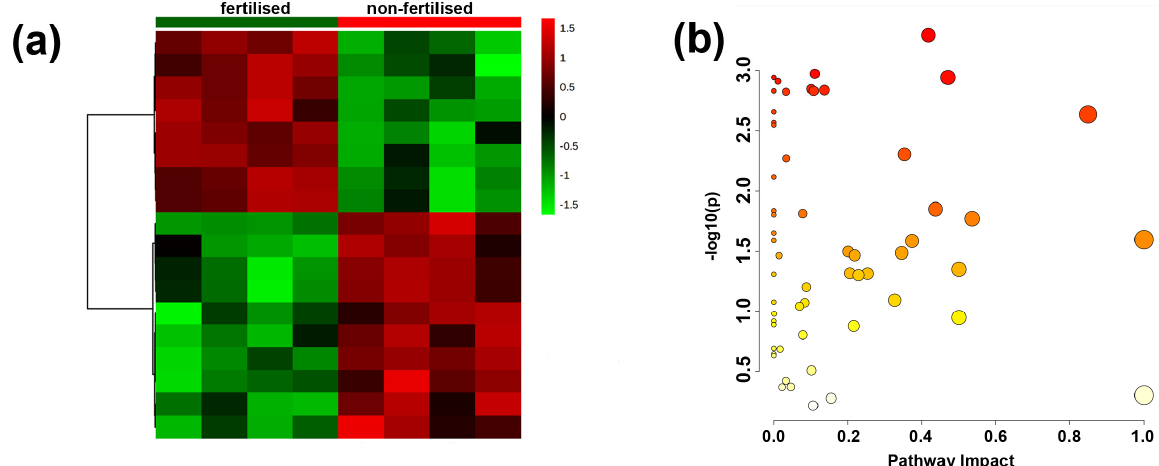
Figure 7. Results of the metabolome data analysis of dry seeds collected from Juniperus communis L. plants grown in fertilised (green) and non-fertilised (red) conditions. ( a ) The clustering result is shown as a heatmap (distance measure using correlation, and clustering algorithm using ward.D); colours represent metabolite relative intensities with red and green symbolising the highest and lowest values, respectively. ( b ) Metabolic pathway analysis plot created using MetaboAnalyst. Plot depicts several metabolic pathway alternations induced by long-term fertiliser availability. The x -axis represents the pathway impact value computed from pathway topological analysis, and the y -axis is the –log of the p -value obtained from pathway enrichment analysis. The pathways that were most significantly changed are characterised by both a high –log( p ) value and a high impact value (top right